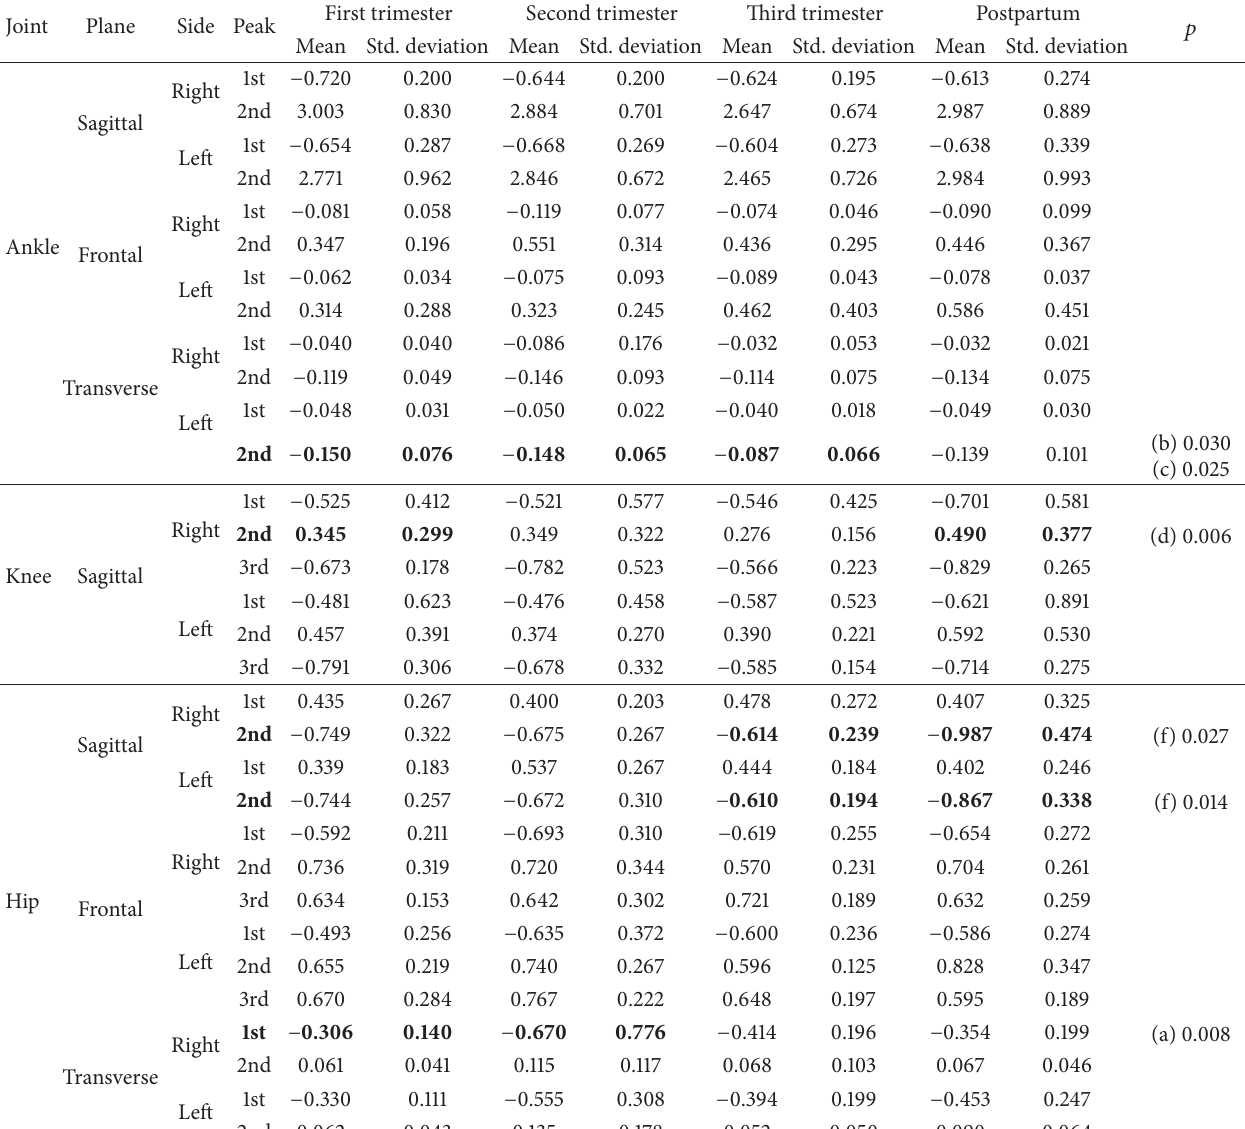
Table 3: Mean and standard deviation of the joint power peaks, and significance levels of the pairs of collections with significant changes for sagittal, frontal, and transverse